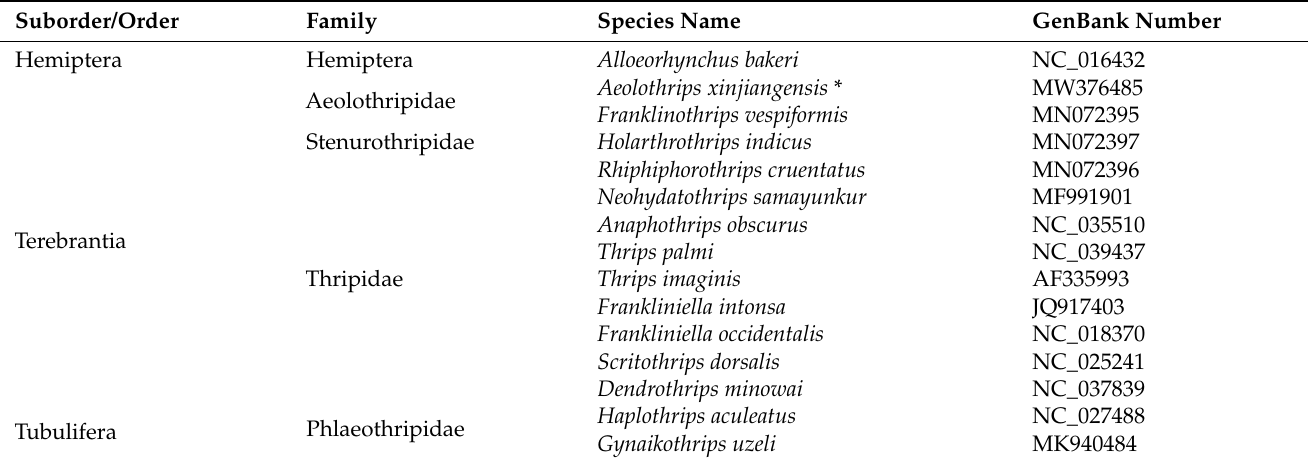
Table 1. Taxa used in this study.